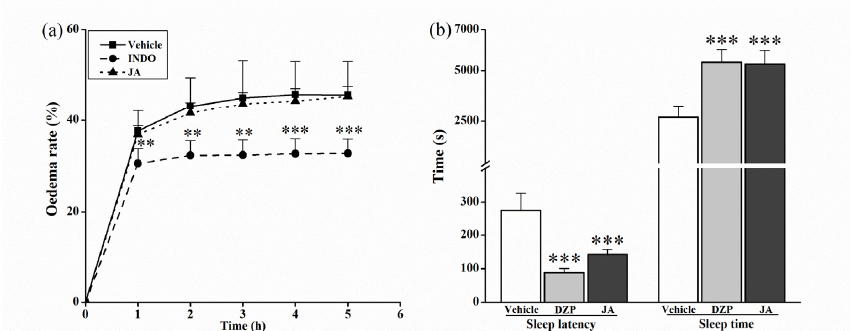
Figure 5. Effect of 3 mg/kg of jegosaponin A (JA) in the mouse paw edema test induced by carra- geenan ( a ) and in the sleep test induced by the pentobarbital sodium ( b ). Vehicle: blank control, INDO: indomethacin, DZP: diazepam. Data are displayed as mean ± SD. ** p < 0.01, *** p < 0.001 vs. vehicle group.